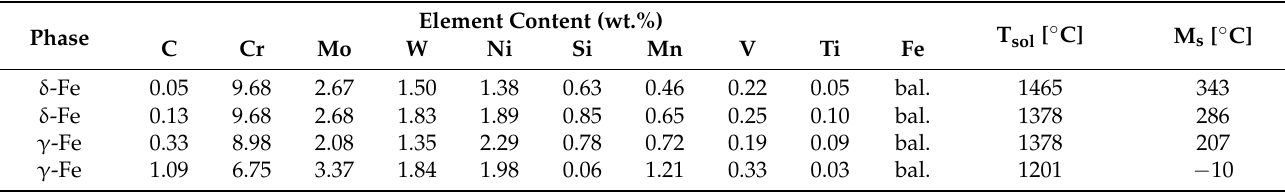
Table 6. Chemical compositions at beginning and end of the solidification of δ -Fe and γ -Fe according to the Scheil-Gulliver